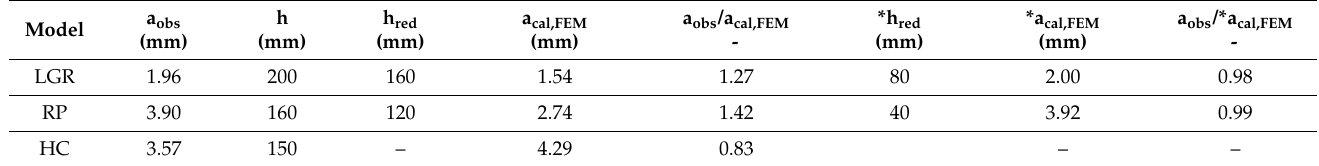
Table 8. Comparison of results from tests and FEM calculations under short-term loading.